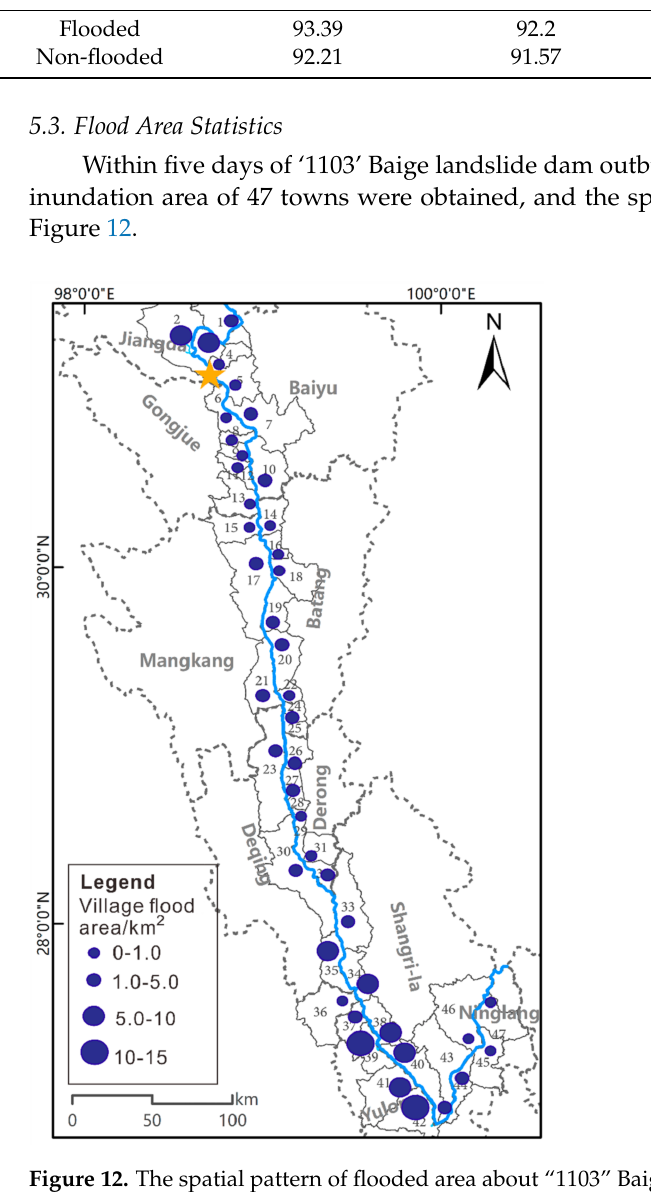
Figure 12. The spatial pattern of flooded area about “1103” Baige Landslide outburst flood. Excluding the original water area (the Jinsha River area was 77.28 km 2 ), the total flooded area amounted to 101.75 km 2 . In the barrier lake region, four townships were disturbed, and Bolo township (NO 2) was the largest, with an area of 9.86 km 2 . Downstream of the outburst point, there were more than 25 townships with the flood inundation area of 0~5 km 2 . The distribution of the larger flood area was closely related to valley topography and mainly concentrated in Jinsha River’s broad and low valley. The five largest-affected towns are all located in the downstream Yu long country, Shangri-la country of Yunnan Province, followed by Judian Town (NO 39), Shigu Town (NO 42), Jinjiang Town